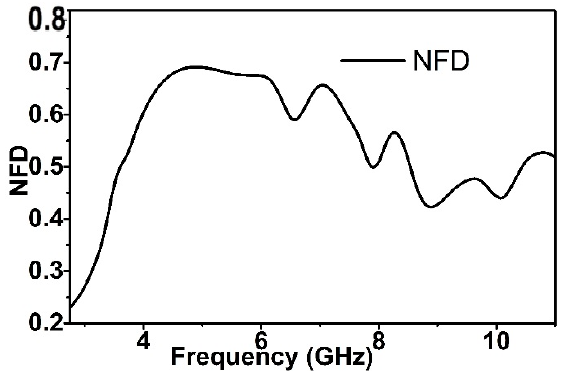
Figure 13. Simulated NFD for the proposed MTM antenna.